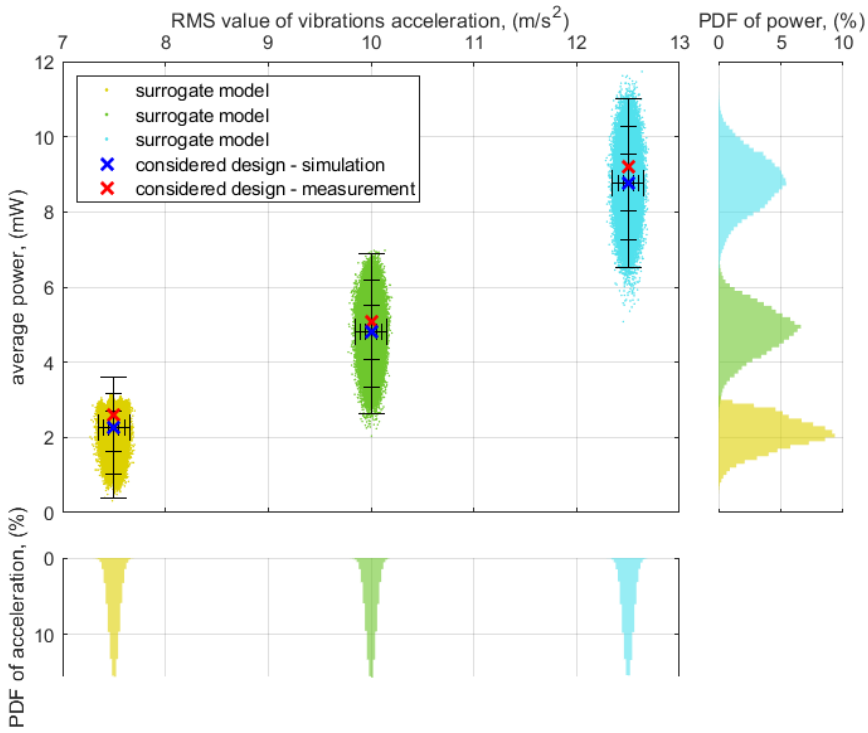
Figure 11. Average power for 10 5 design points with probability density functions (PDF) and errorbars denoting confidence levels considering only the deviations of beam dimensions.